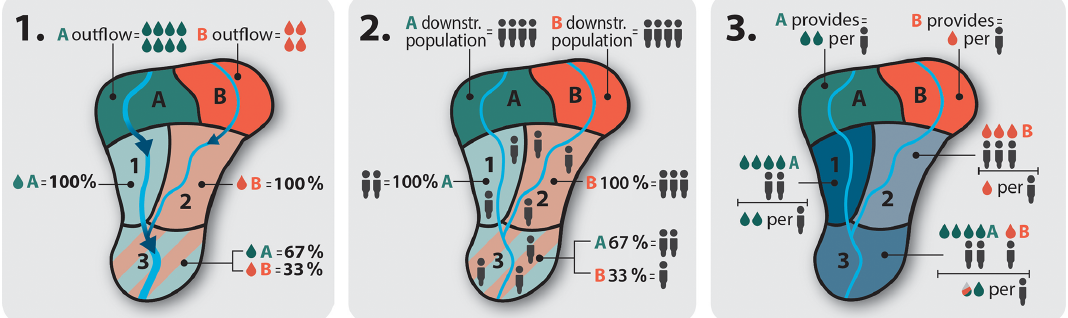
Figure 2. Conceptual representation of the allocation of upstream sub-basin water resources to downstream sub-basins. First, (1) the relative contribution of each upstream sub-basin to the total upstream inflow of each downstream sub-basin is determined. Next, (2) the population of each downstream sub-basin is determined and assigned to the upstream sub-basins by their relative flow contribution. Lastly, (3) upstream outflows are divided by their total assigned downstream populations to obtain the per capita upstream water availability they provide to the downstream sub-basins. The upstream per capita water availability per downstream sub-basin is the mean per capita availability provided by all contributing upstream basins, weighted by their assigned populations. The total per capita water availability of a downstream sub-basin is determined by aggregating the local downstream per capita water availability and the upstream per capita water